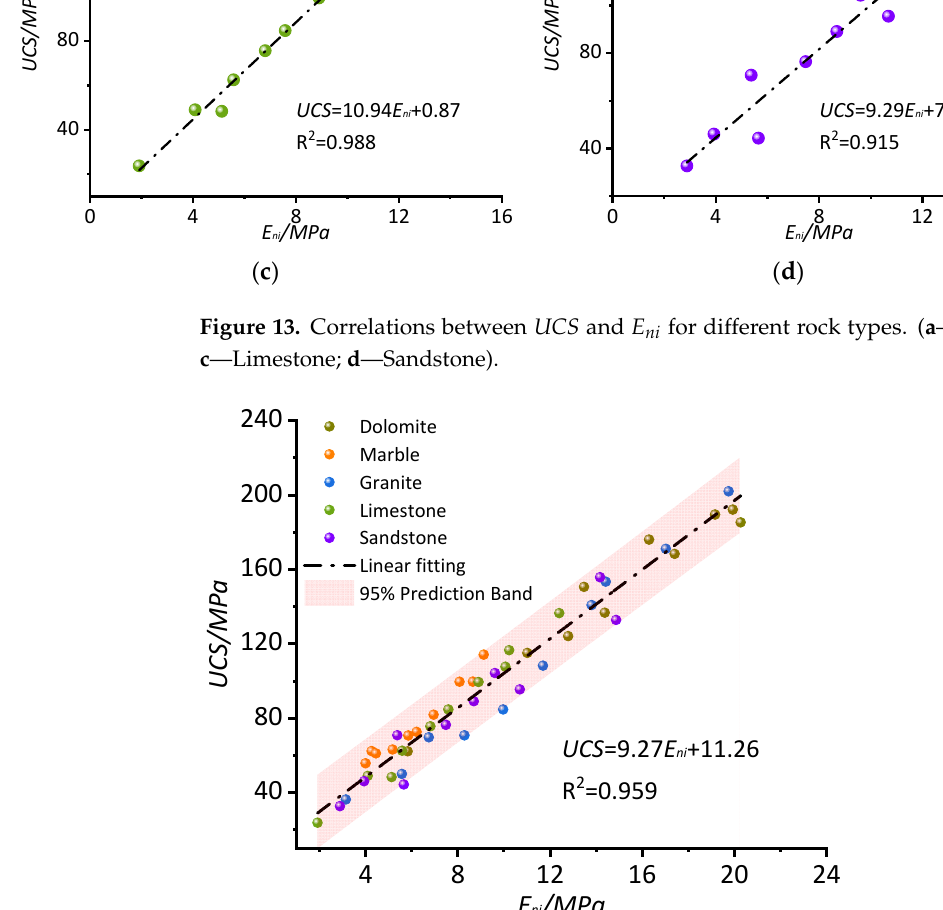
ni for all the rock